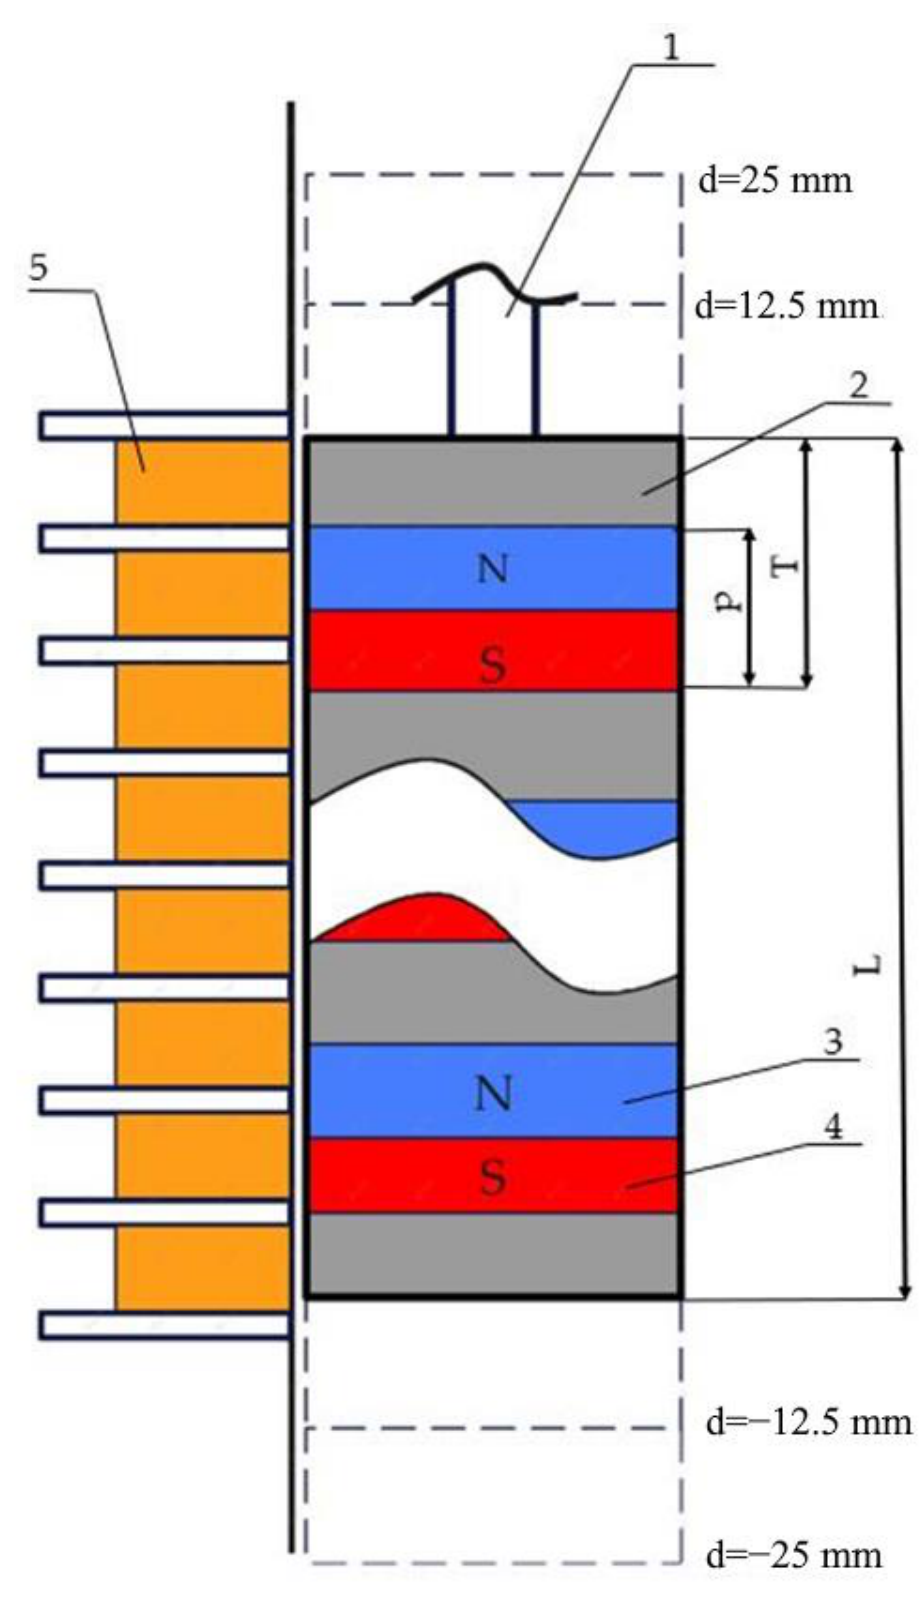
Figure 3. Schematic positions of permanent magnets in the slider. 1—slider rod; 2—non-magnetic material; 3—north magnetic pole; 4—south magnetic pole; 5—coils. Here, L—length of the slider, p—magnet height, and T—period of the segment (magnet plus non-magnetic insert).